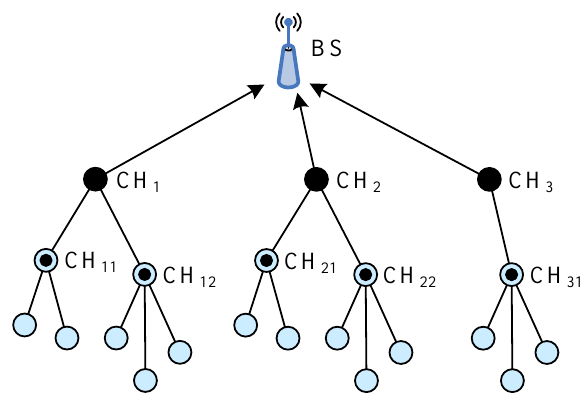
Figure 5. The Two-level Hierarchy in